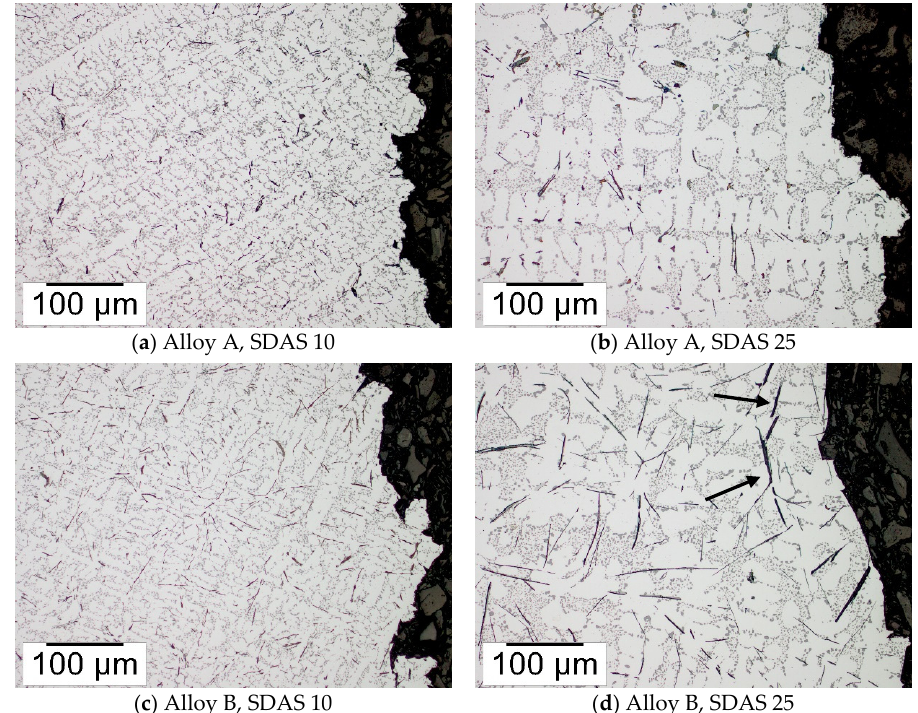
Figure 10. Micrographs of the microstructure towards the fracture surfaces of alloy A in ( a , b ) and alloy B in ( c , d ). In ( d ) are the arrows indicating secondary cracks of β‐ particles. The samples are etched with H 2 SO 4 in order to highlight the Fe ‐ rich